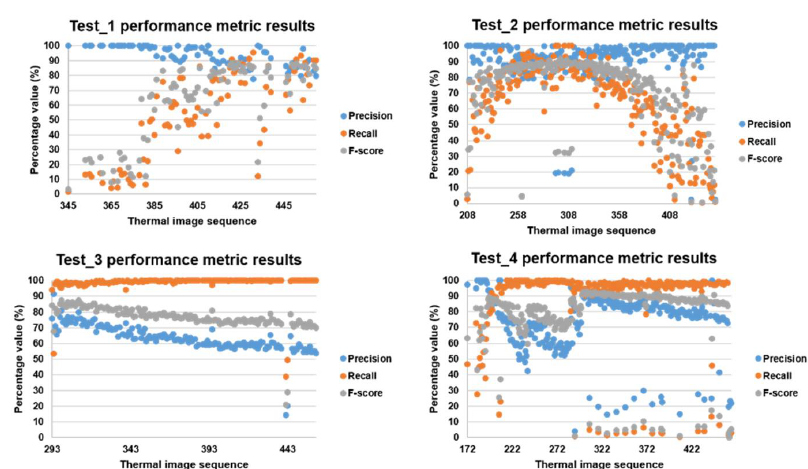
Figure 10. Precision , Recall and F-score results regarding the delimitations obtained in each test performed in this work.